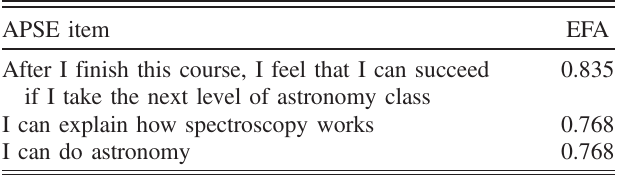
TABLE II. The three highest loading items contributing to factor 1.